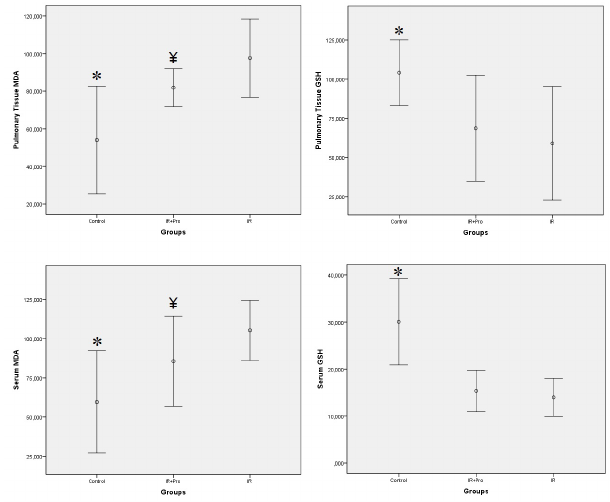
Fig. 1 – Results of serum and lung tissue oxidative stress